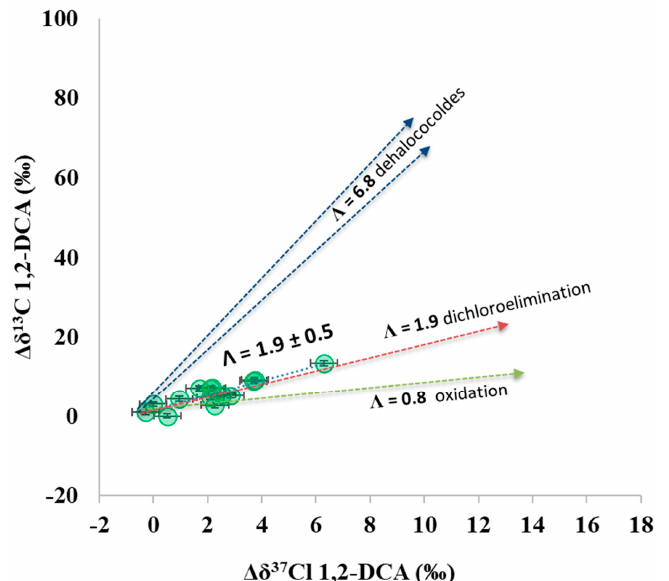
Figure 8. Dual isotope approach reporting the variation of δ 13 C and δ 37 Cl for the pilot area; Λ values for oxidation, dichloroelimination and Dehalococcoides sp. are the values reported in Palau et al.,